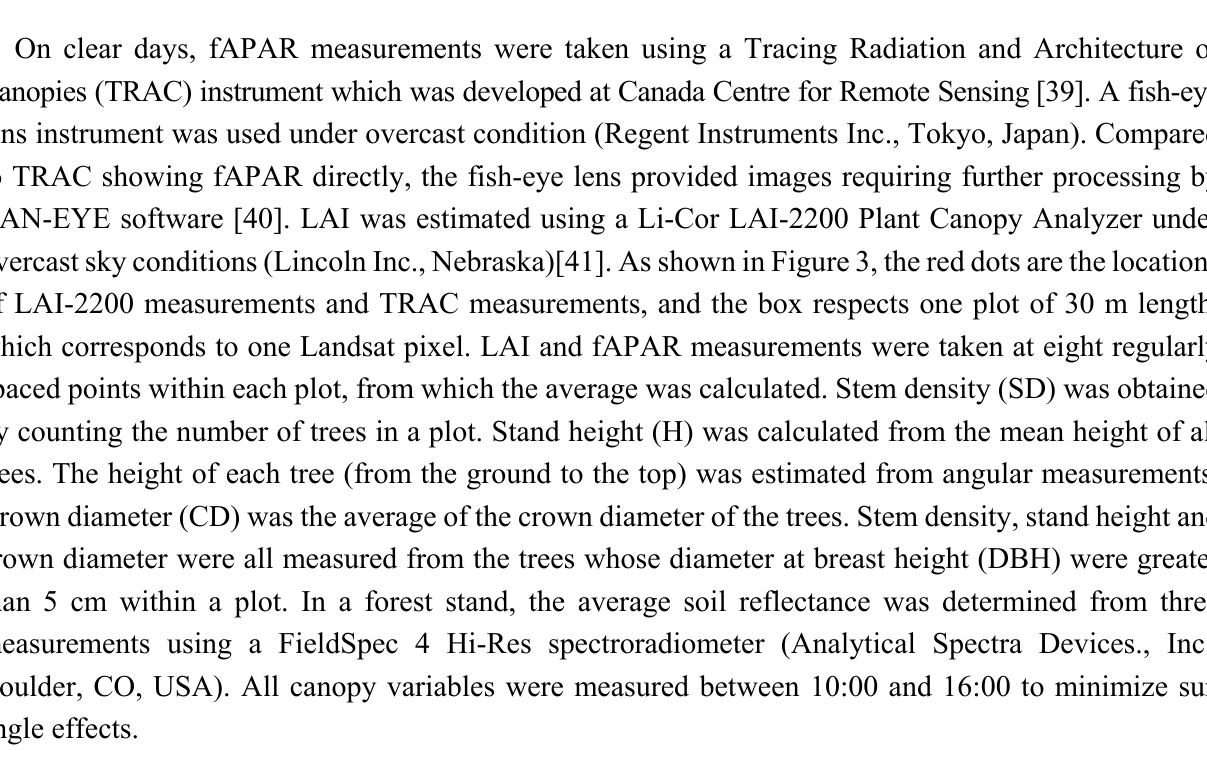
Table 2. Summary statistics for field measured fraction of absorbed photosynthetically active radiation in forests (fAPAR) and forest stand variables ( n = 42).